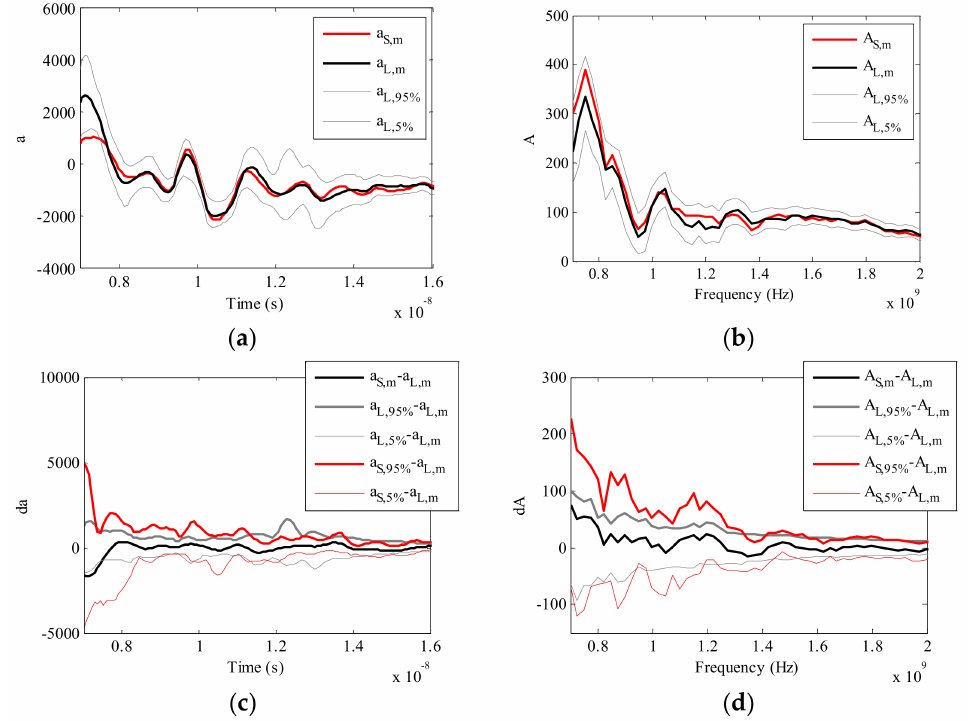
Figure 4. Examples of GPR signal processing steps: ( a ) amplitude in the selected time range; ( b ) amplitude in the selected frequency range; differences in amplitude between the short window, S and the larger window, L , in time domain, da ( c ) and in frequency domain, dA ( d ). Examples of spectrograms of a and A , over a length of 200 m (the larger sliding window—L), are presented in Figure 5 with the identification of the short sliding window inside the dotted red rectangles.